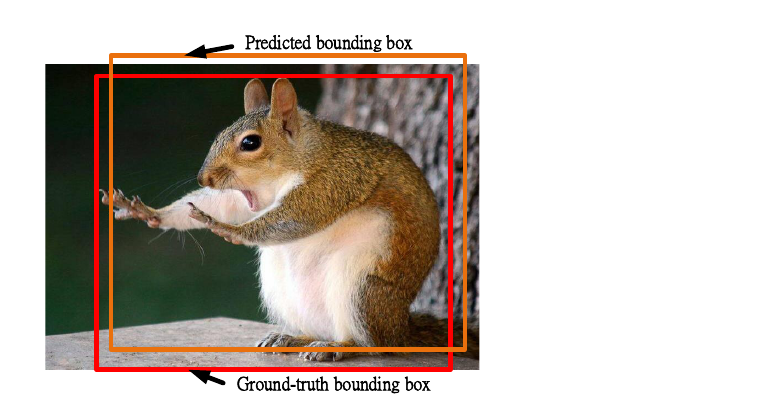
Figure 23. Schematic diagram illustrating the predicted and actual bounding boxes.